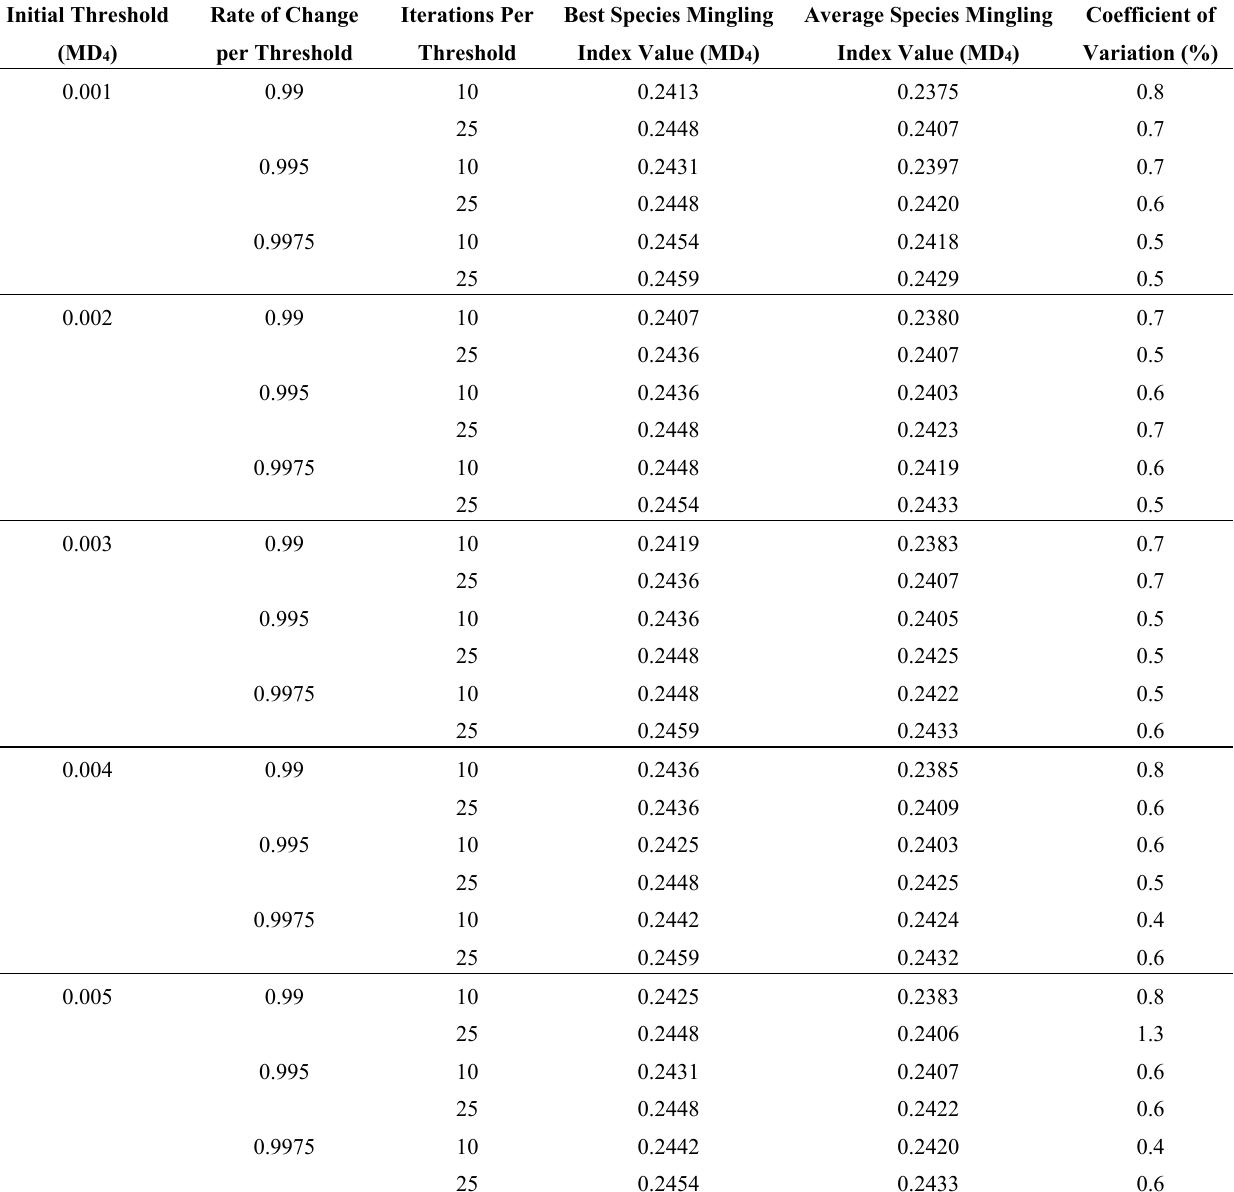
Table 6. Results of the application of threshold accepting to a tree-level harvest schedule of an uneven-aged mixed-conifer stand in eastern Oregon (western United States), based on maximizing the species mingling index and using unique tree species as